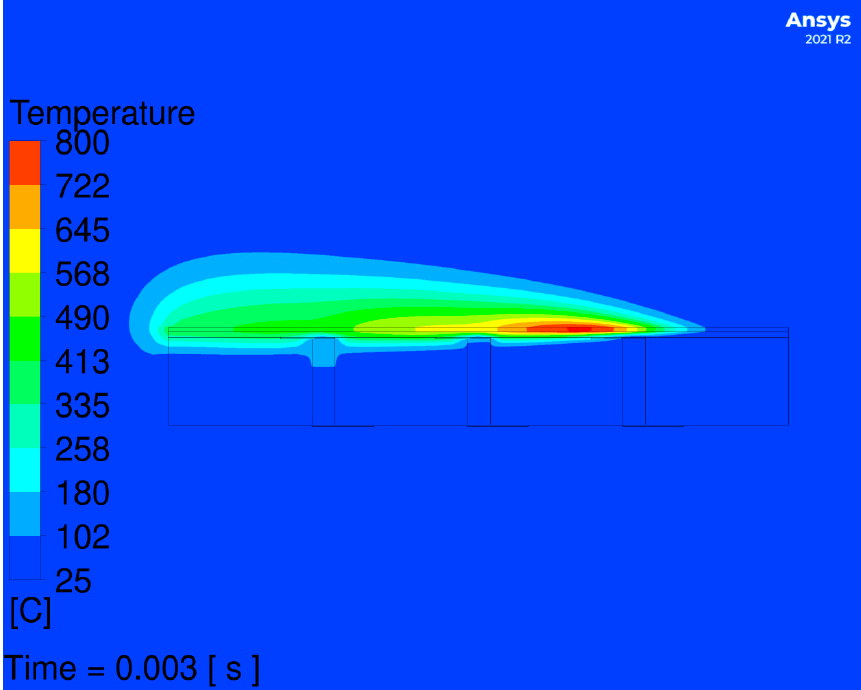
Figure 14. Temperature contours after 3 ms, without solder and silicon.